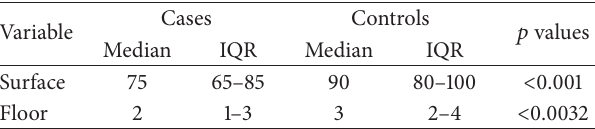
Table 2: Median surface area and floor of residence in cases and controls.